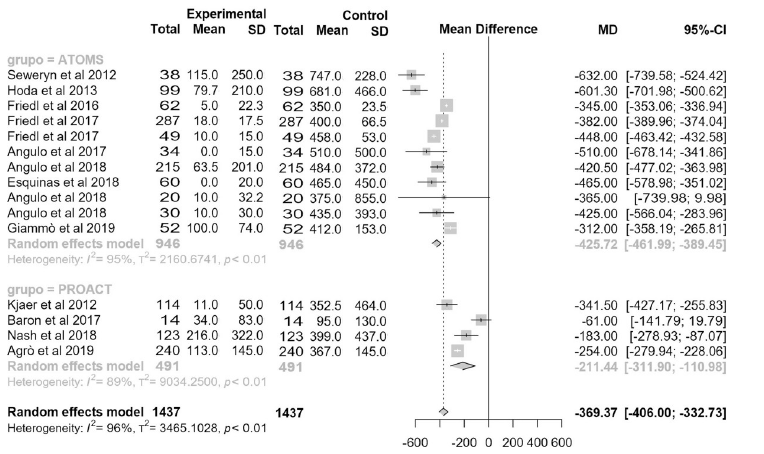
Fig 7. Forest plot of studies analyzed with differential pad-test expressed in